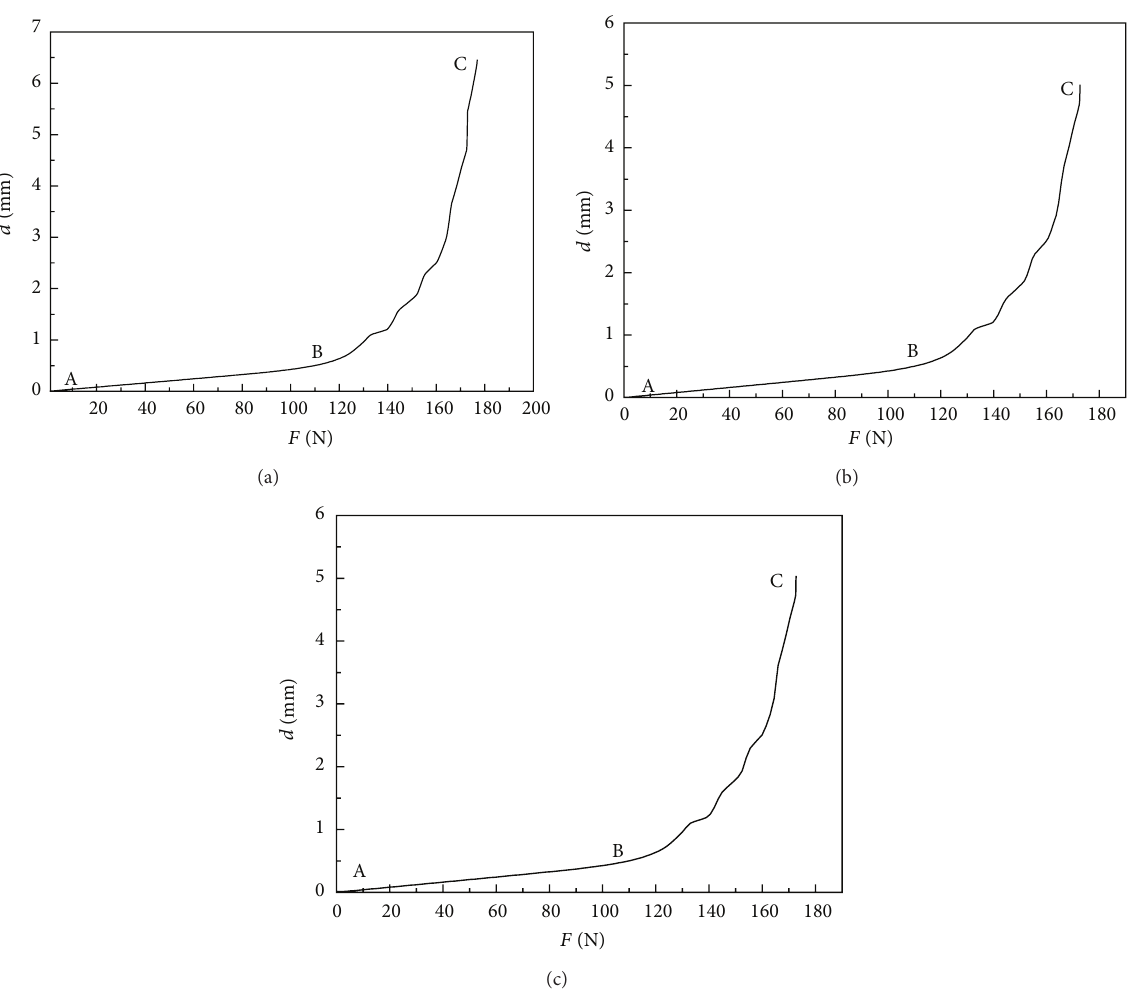
Figure 6: The results of finite element simulation. (a) The relationship between the bending deflection and the applying load of the reference point. The load spectrum is 𝐹 = 𝑡 ; (b) the relationship between the bending deflection and the applying load of the reference point. The load spectrum is 𝐹 = 2𝑡 ; (c) the relationship between the bending deflection and the applying load of the reference point. The load spectrum is 𝐹 = 3𝑡 .